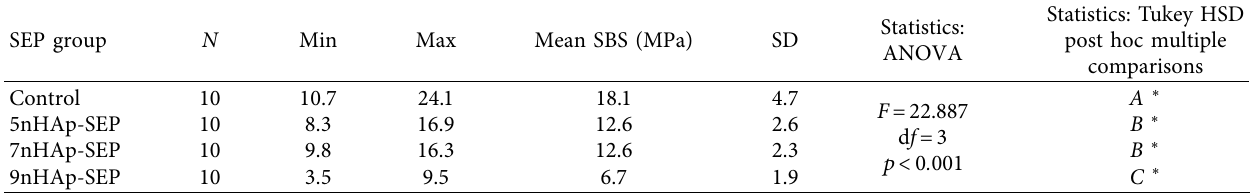
Table 2: Descriptive and inferential statistics of pilot shear bond strengths (SBSs) of bracket debonding at 24h water